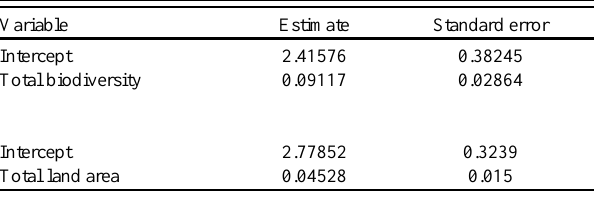
Table 2 . Parameter estimates for variables selected in the two best models of social-ecological factors and the proportion of endangered birds in 100 different countries.